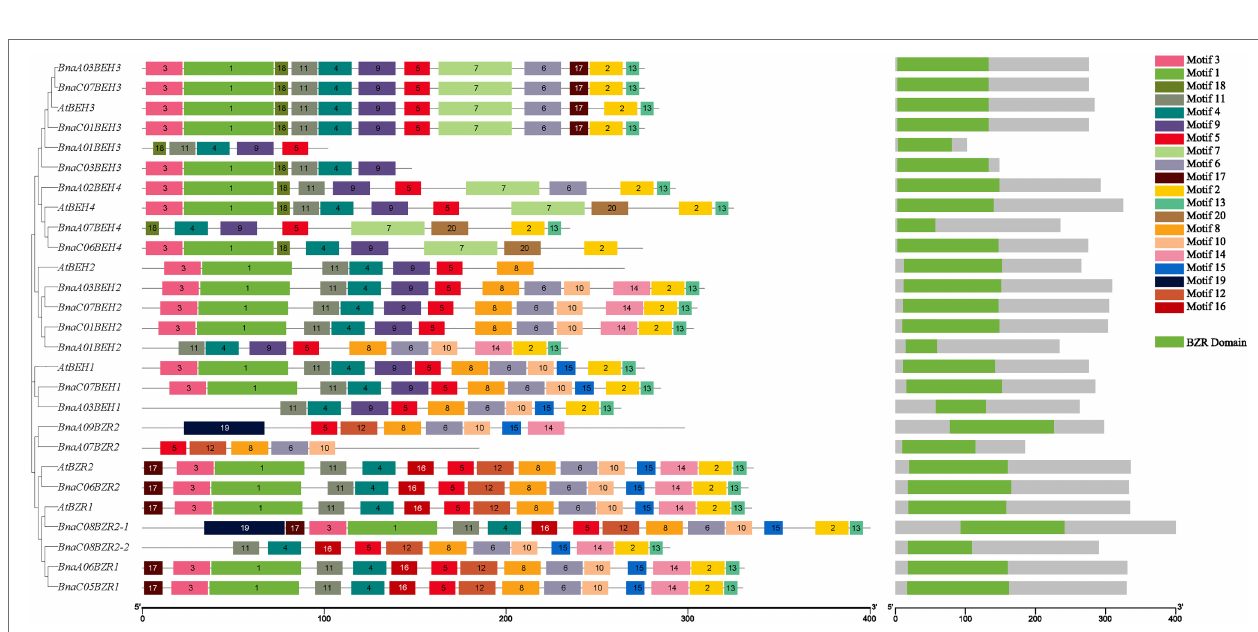
FIGURE 3 | 3D model of the BnaA06BZR1 protein. The BZR1 domain was highlighted in pink, and the yellow color indicates the specific amino acid sites that are involved in functional divergence.